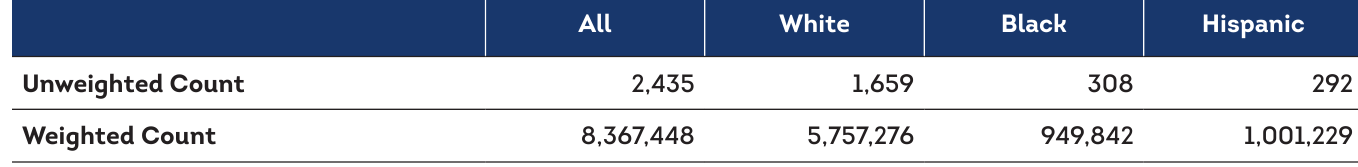
Table A4: Knowledge of diabetes self-management and Medicare coverage, by race/ethnicity All White